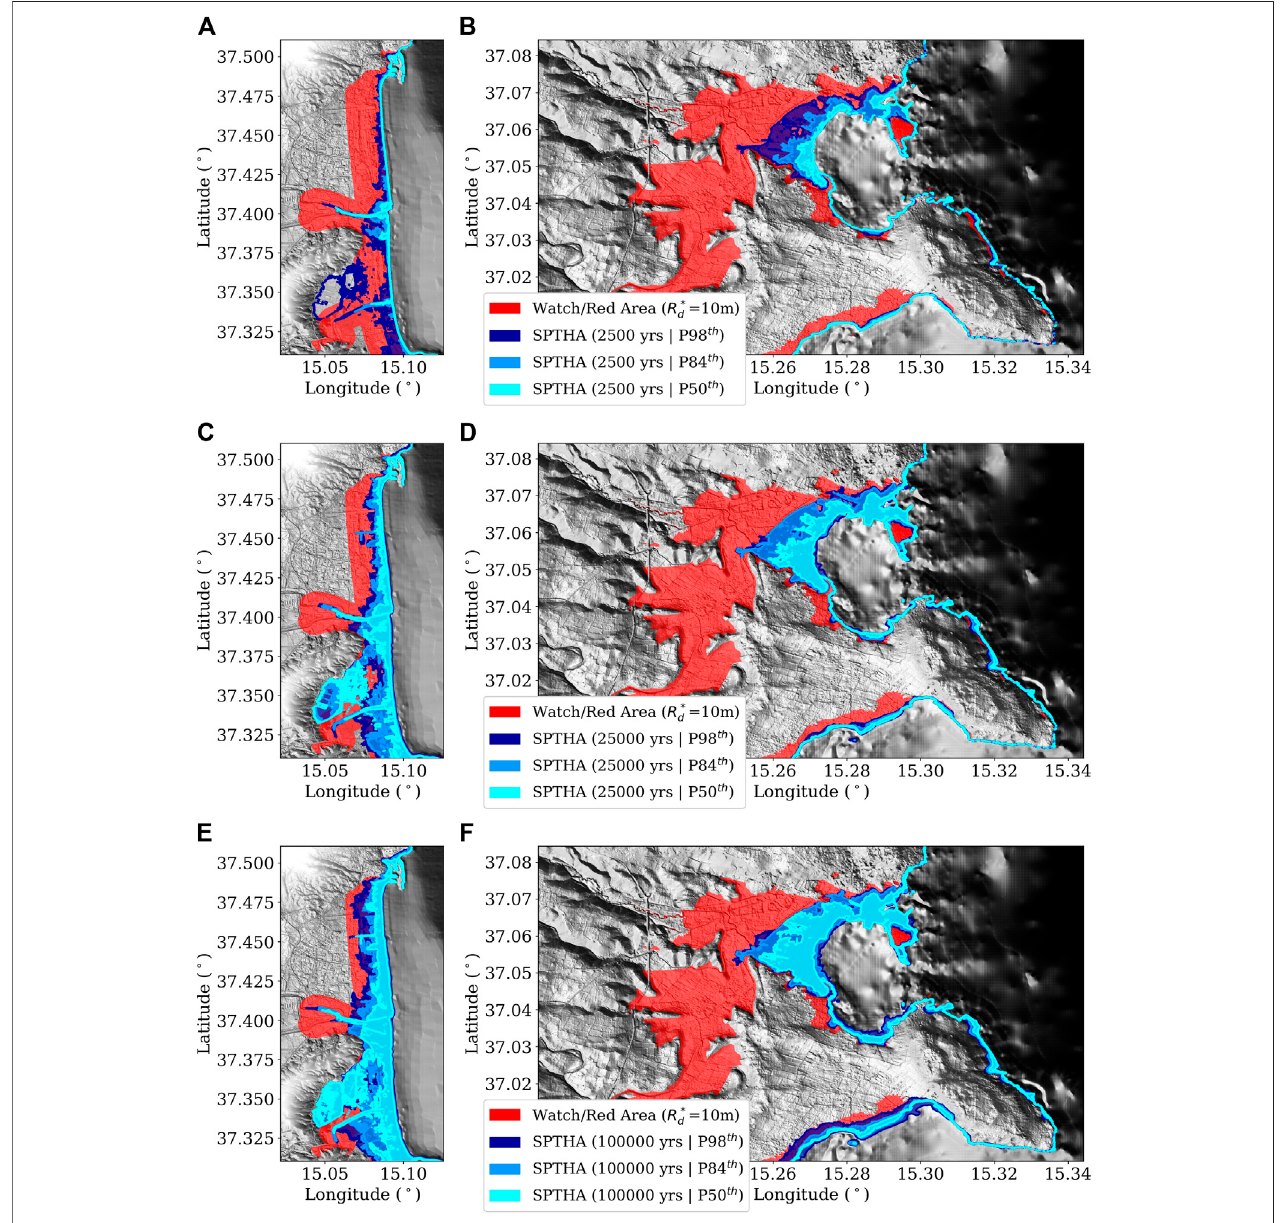
FIGURE11 | Comparison between the Watch/Red areas designed for R p d (cid:1) 10m and inundationmaps obtained for differentSPTHA ’ spercentiles(50th, 84th and 98th) and different ARPs (2,500, 25,000 and 100,000 years in both Catania [panels (A, C, E) ] and Siracusa [panels (B, D, F) ].